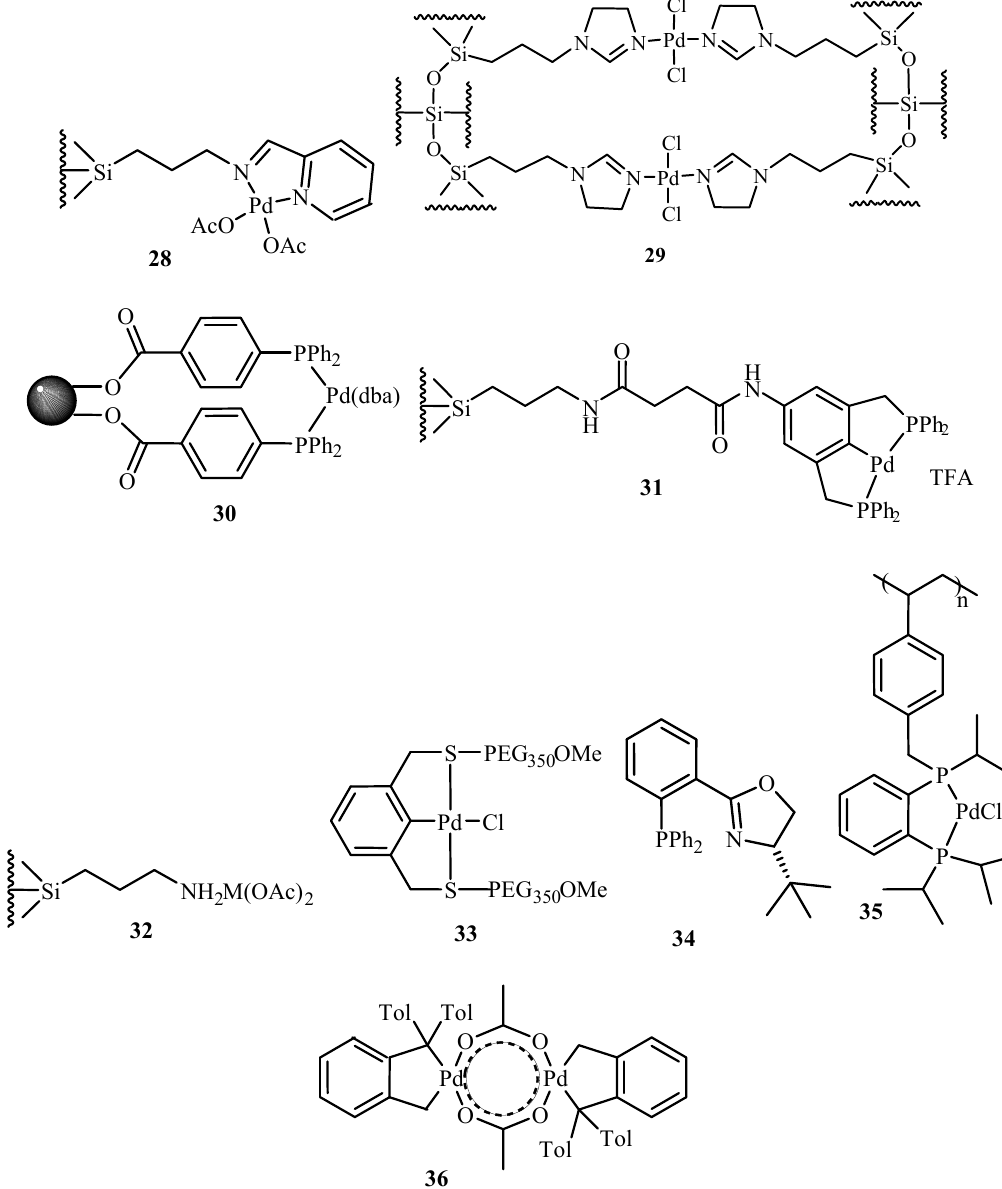
Figure 4. Ligands and catalysts employed for Heck reaction reported in review by Kobeti´c and Biliškov